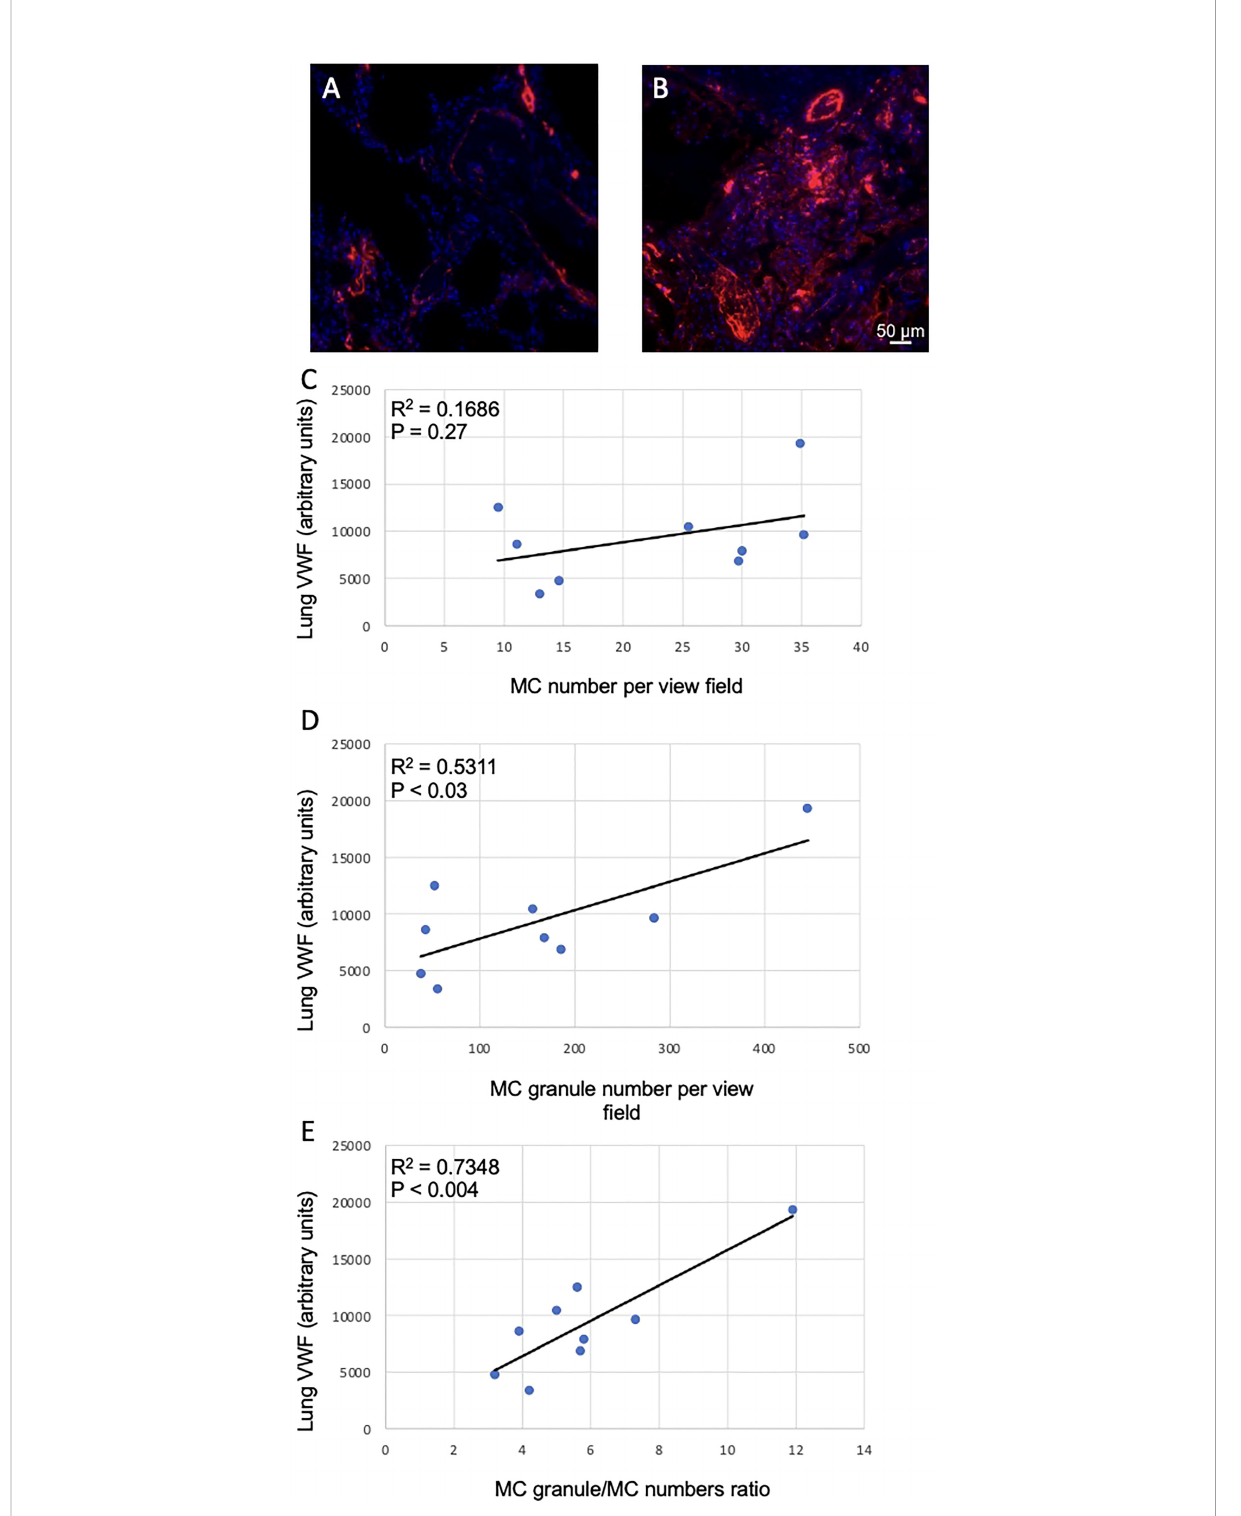
FIGURE 4 Correlation between MC-related parameters and lung VWF levels. The levels of VWF in the lungs were determined as fl uorescence intensity in arbitrary units. (A) and (B) , representative images of VWF staining in the lungs of non-COVID-19 and COVID-19 patients, respectively. Correlations of VWF levels with (C) MC numbers, (D) cell-free granule numbers and (E) granule/MC number ratio are presented. Pearson r coef fi cient was calculated using MS